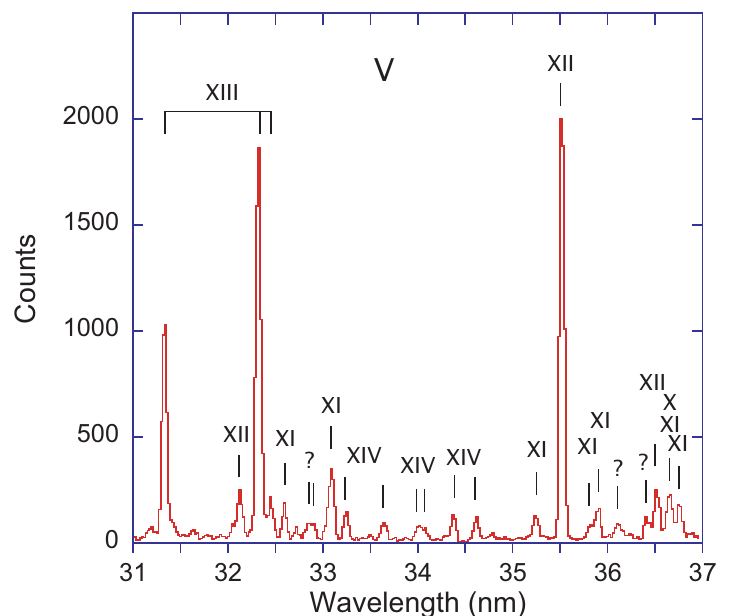
Figure 8. Beam-foil spectrum of V at an ion beam energy of 14MeV. Observation at the foil. Line width (FWHM) 0.06nm. The strongest lines are identified by the spectrum